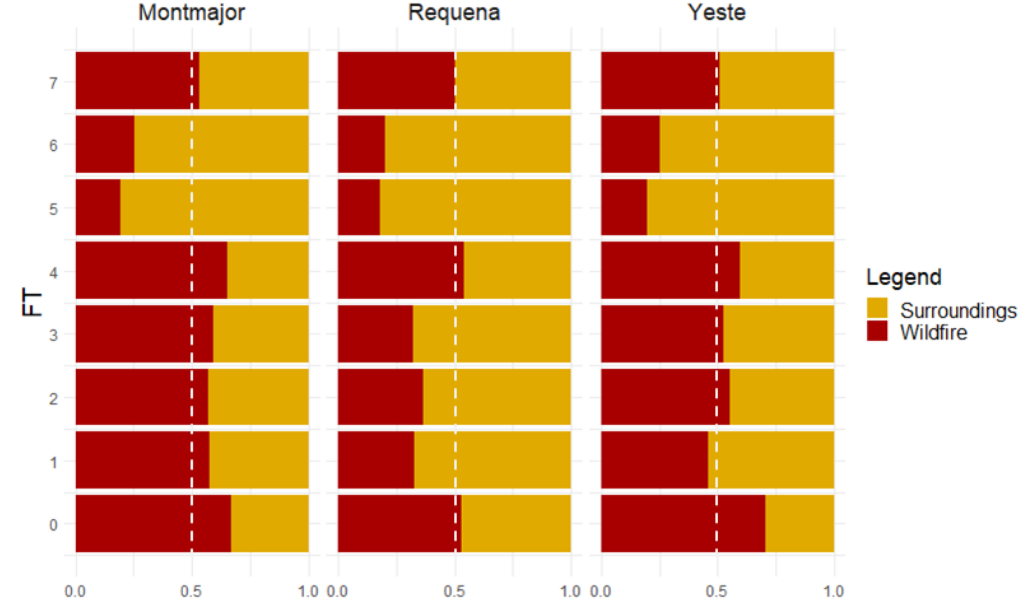
Figure 4. Relative presence, expressed between 0 and 1, of fuel types in areas affected by the three wildfires or their surroundings.